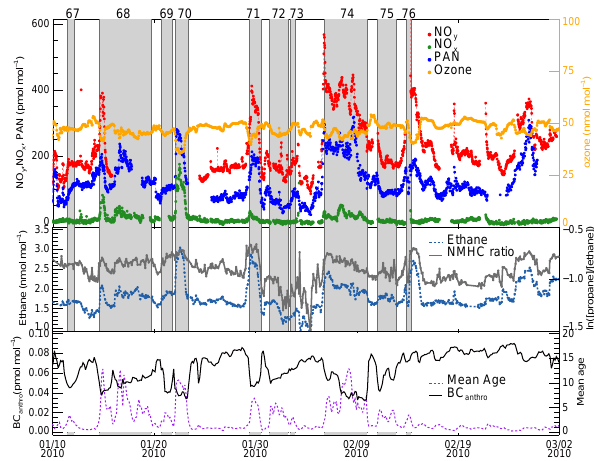
Figure 7. The top plot shows 30min averages of NO x , NO y , PAN, and 1h average of O 3 from Summit between 10 January and 2 March 2010. The middle plot shows ethane mole fraction and ln ( [ propane ] / [ ethane ] ) , and the bottom plot shows the FLEX- PART BC anthro tracer emissions (from all continents), and mean weighted age, for the same period. The shaded areas indicate the events discussed in detail in the main text and numbers at the top of the plot represent the event number (see Supplement for details on the